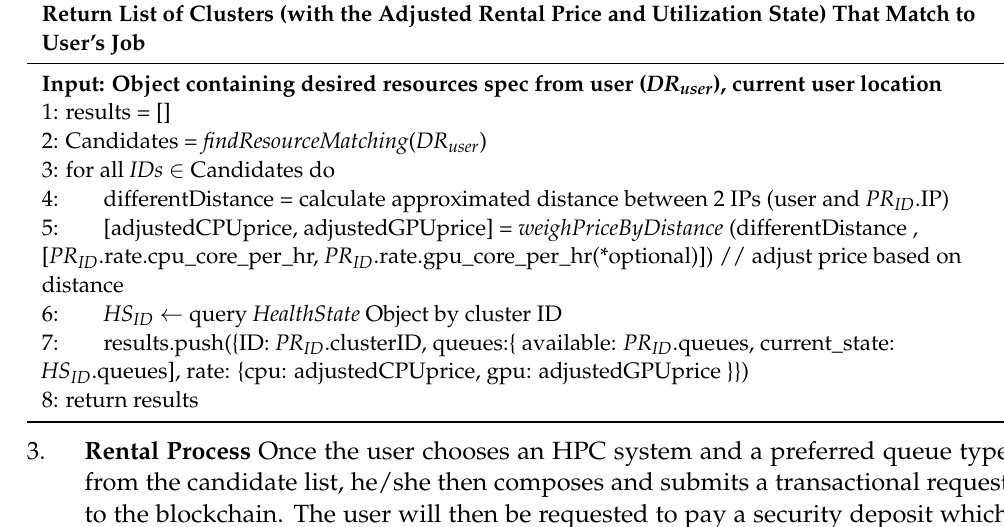
Algorithm 2. Pseudocode of displayResourcesAndRentalPrice